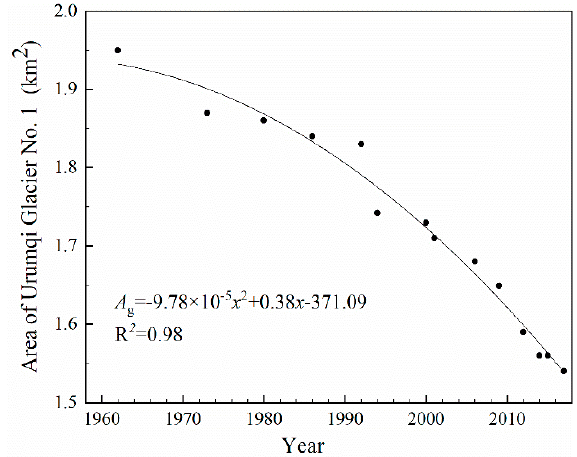
Figure 2. Observed areas (black circles) and its fitting curve and regression equation for Urumqi Glacier No. 1.